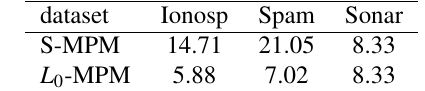
Table 6. Comparison of PSF ( % ) between L 0 -MPM and S- MPM dataset